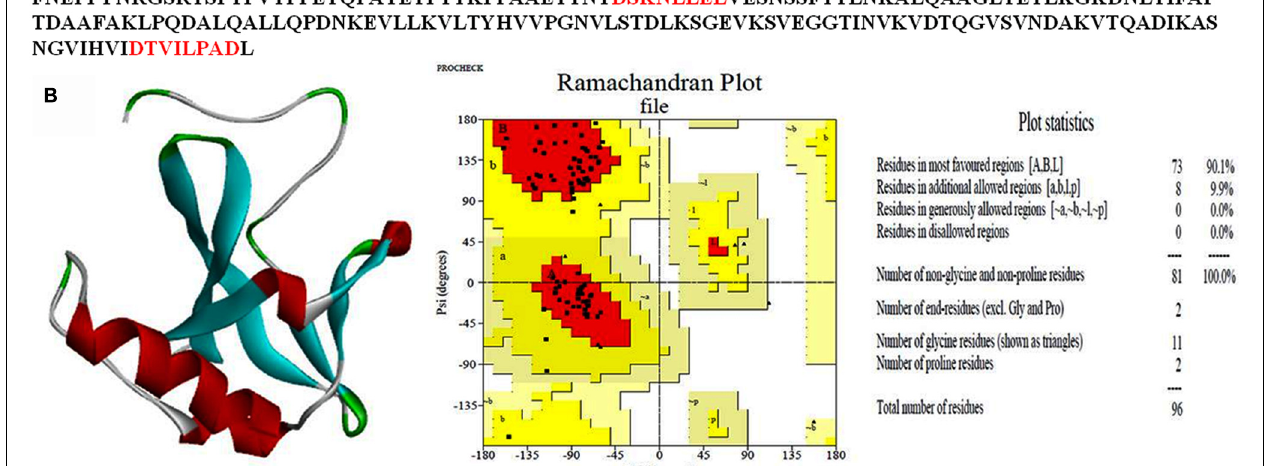
Prediction of functional domains, UTR, motif analysis, and